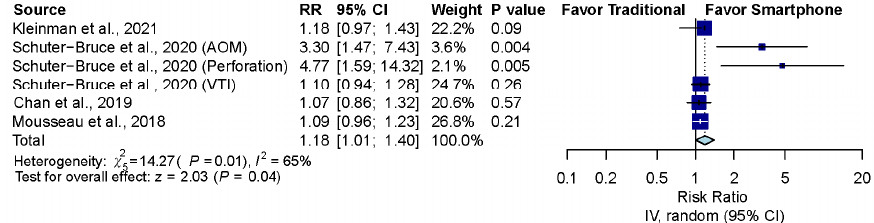
Figure 5. Sensitivity analysis after excluding normal ear conditions.